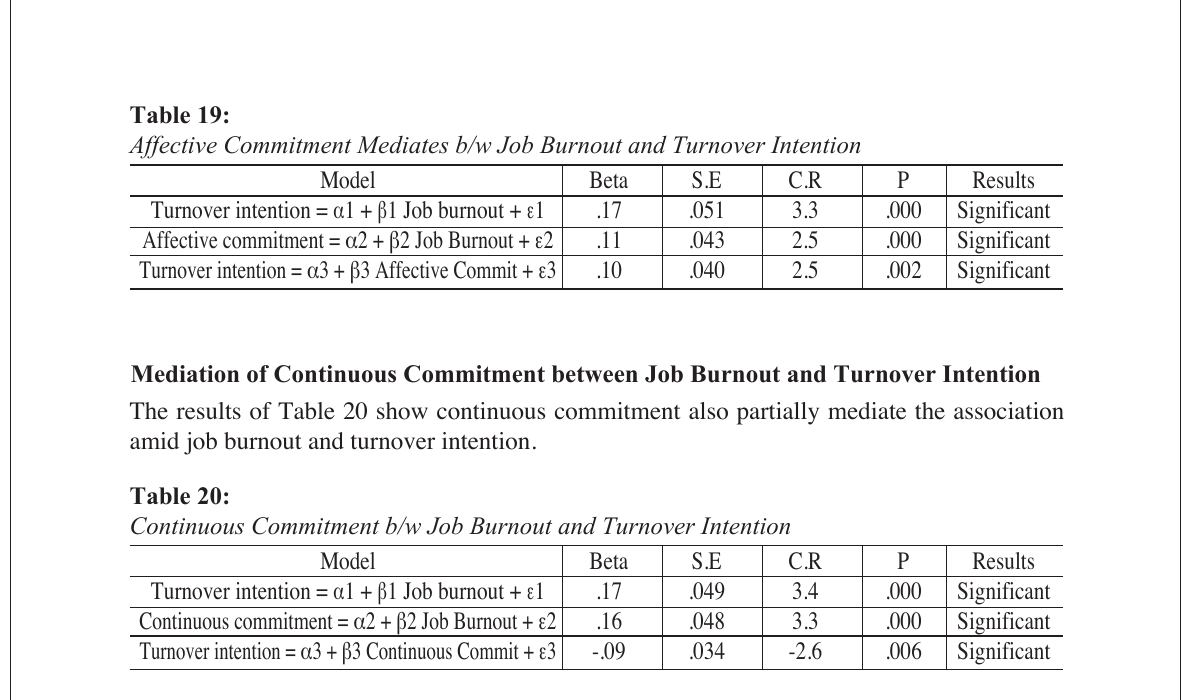
The results show continuous commitment also partially mediates the association amid job